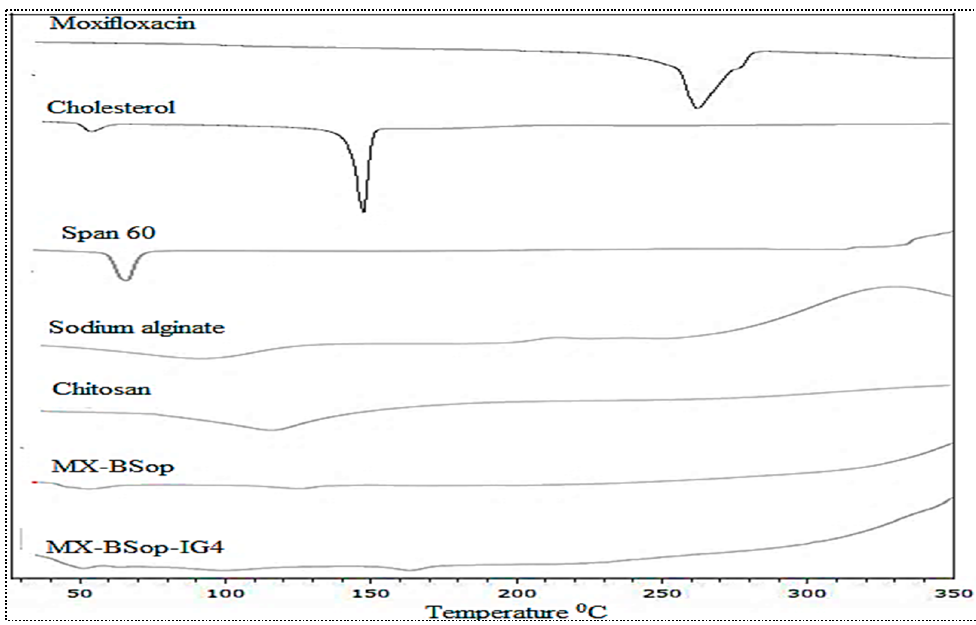
Figure 7. DSC thermogram of moxifloxacin, cholesterol, Span 60, sodium alginate, chitosan, optimized moxifloxacin bilosomes (MX-BSop), and optimized moxifloxacin bilosome in situ gel (MX-BSop-Ig4).